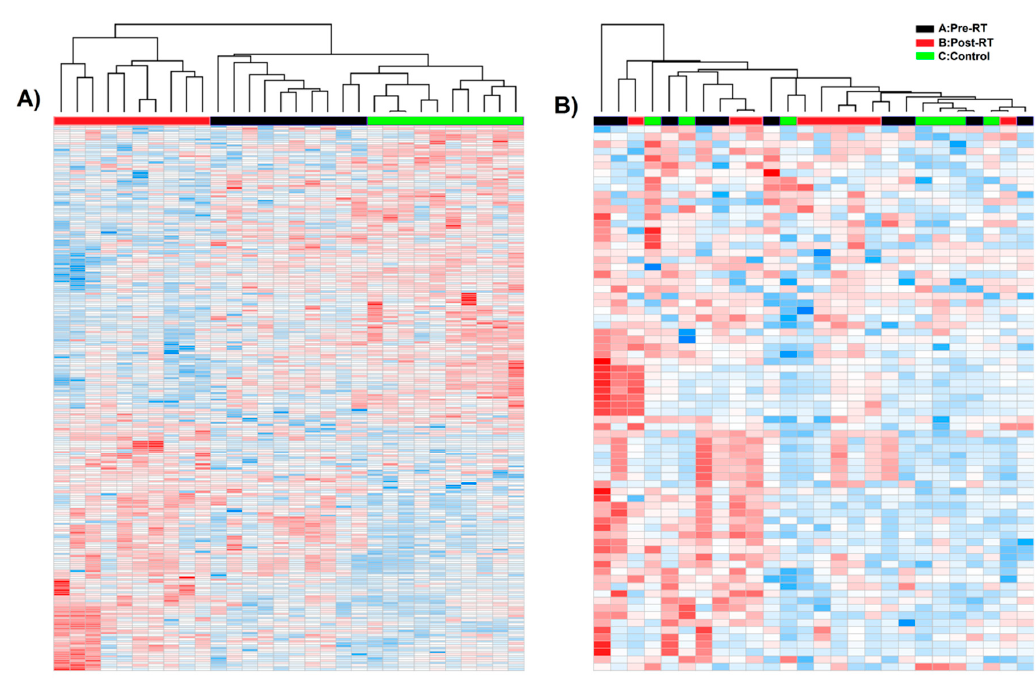
Figure 4. Hierarchical cluster analysis of cancer pre-RT samples A, cancer post-RT samples B, and control samples C. Shown are separate dendrograms for serum samples (panel A ) and exosome samples (panel B ).